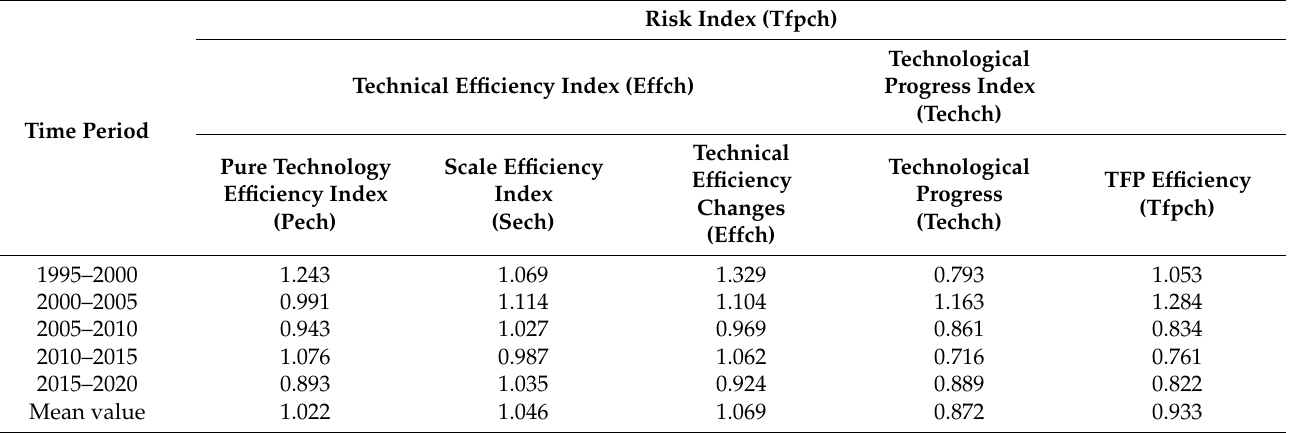
Table 3. Agroecological risk index and decomposition of water in the HRB by time period,